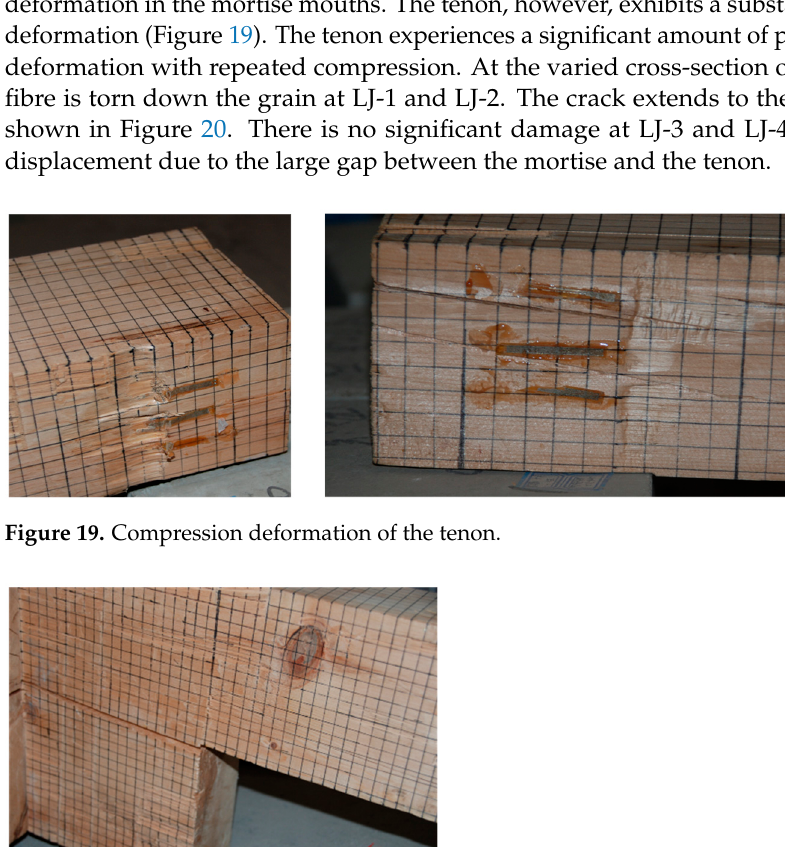
Figure 20. Wood fibre torn along the grain at the variable cross-section of the tenon.